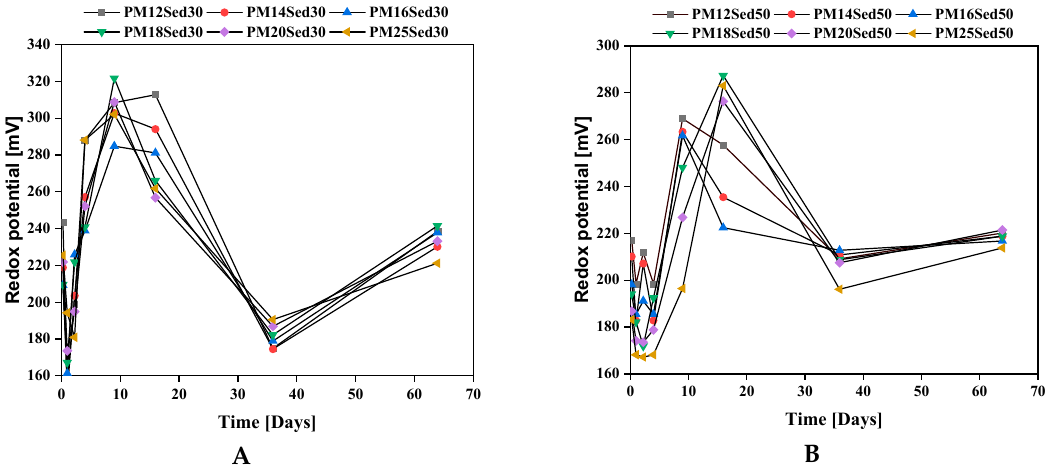
Figure 8. Evolution of redox potential in the leachates from monolithic polymer mortars containing 30% ( A ) and 50% ( B ) of sediments in their matrices.